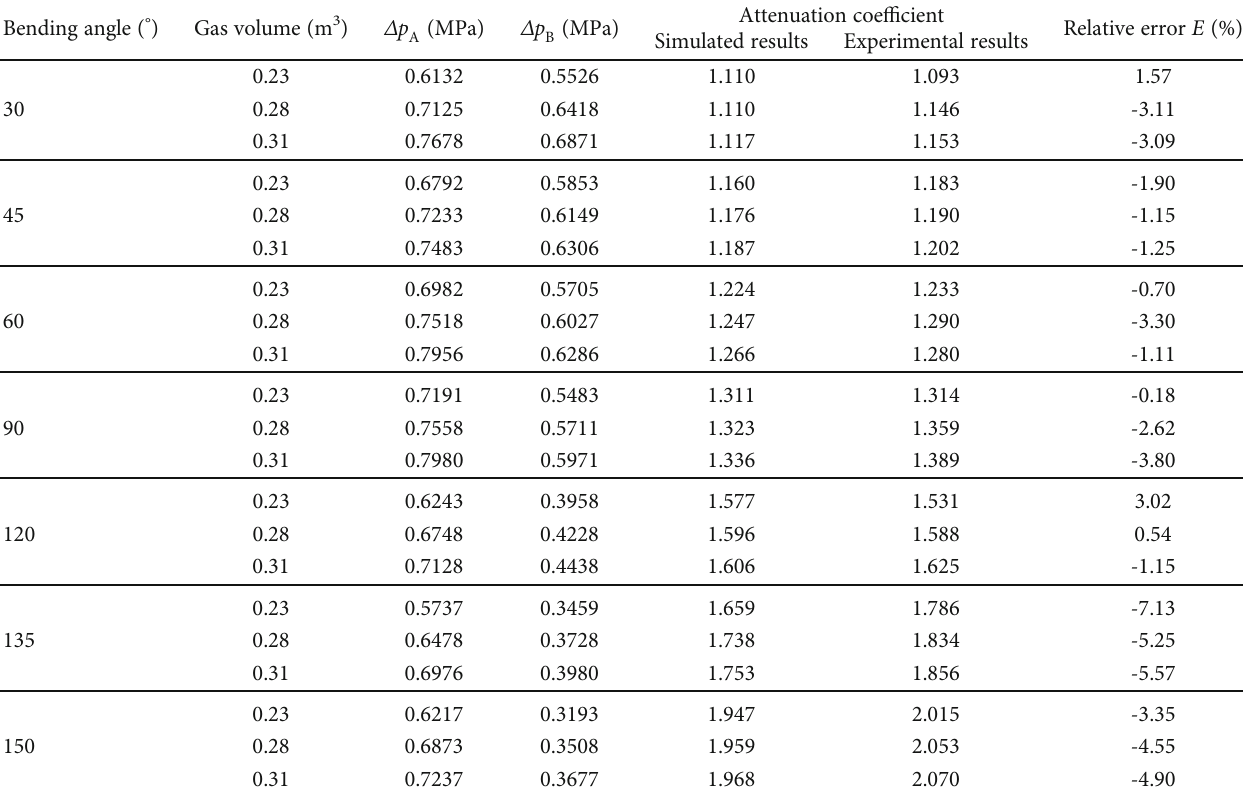
Table 4: Comparison of simulated and experimental